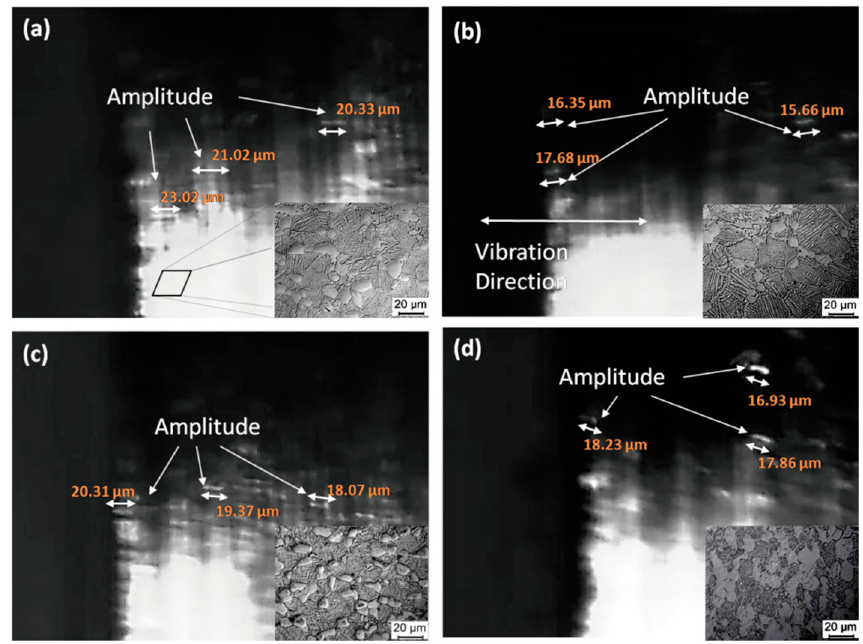
Figure 8. Images of the vibrating and microstructure of Ti6Al4V alloy vibrator under different heat treatment: ( a ) 960 ◦ C × 1 h, AC; ( b ) 980 ◦ C × 1 h, AC; ( c ) 960 ◦ C × 1 h, AC + 600 ◦ C × 2 h, AC; and ( d ) 960 ◦ C × 1 h, AC + 750 ◦ C × 2 h, AC.